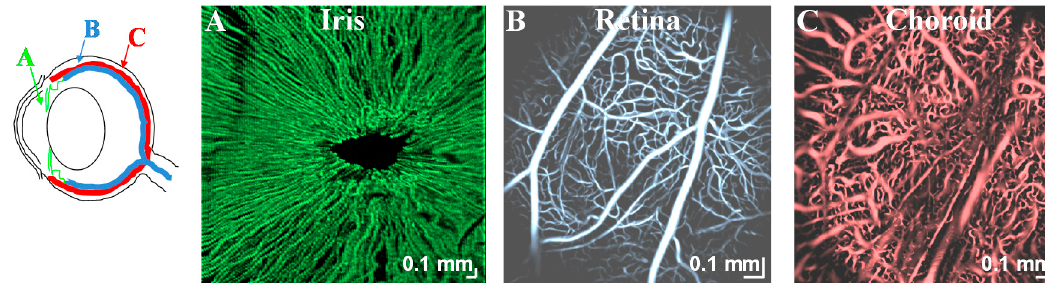
Figure 8. Ocular OCTA of iris ( A ), retina ( B ), and choroid ( C ). Hessian vesselness enhancement was applied to retinal and choroidal vasculature before display. Note that the pupil was dilated prior to OCTA acquisition for ( B , C ).